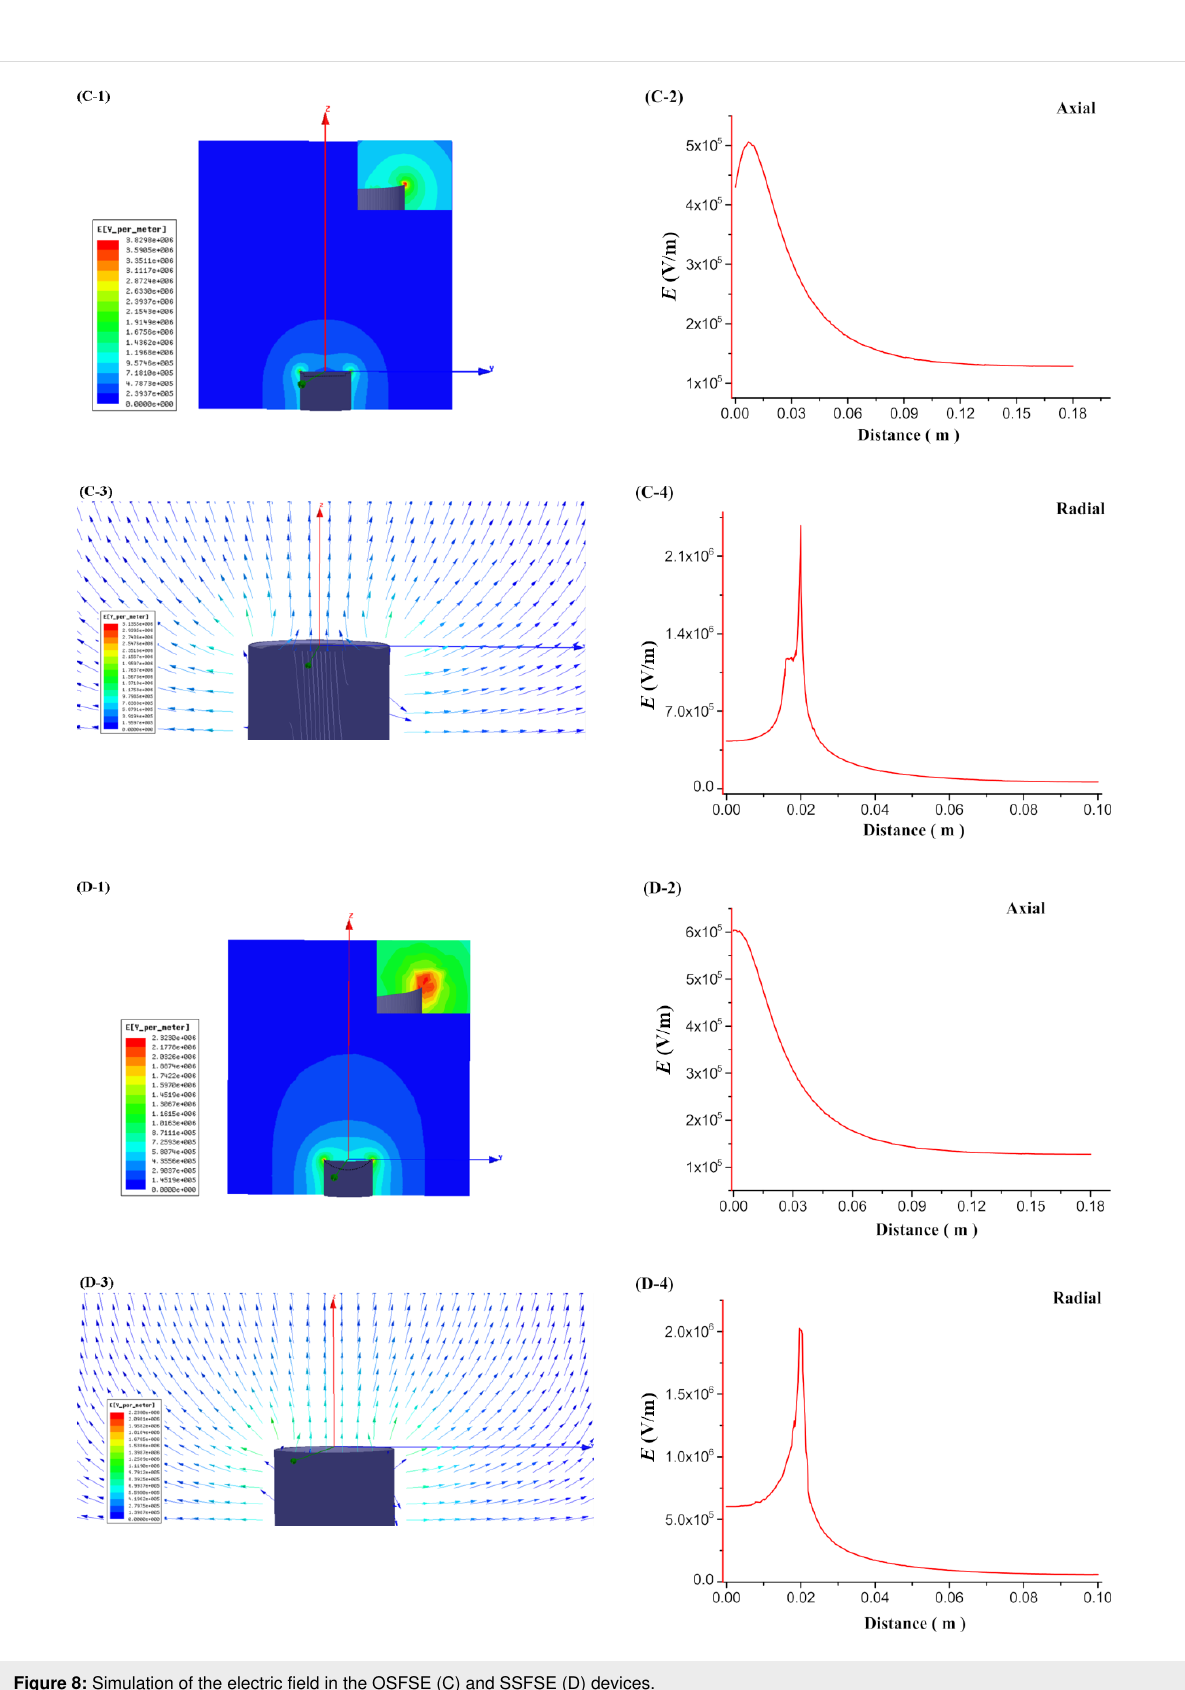
Figure 8: Simulation of the electric field in the OSFSE (C) and SSFSE (D)